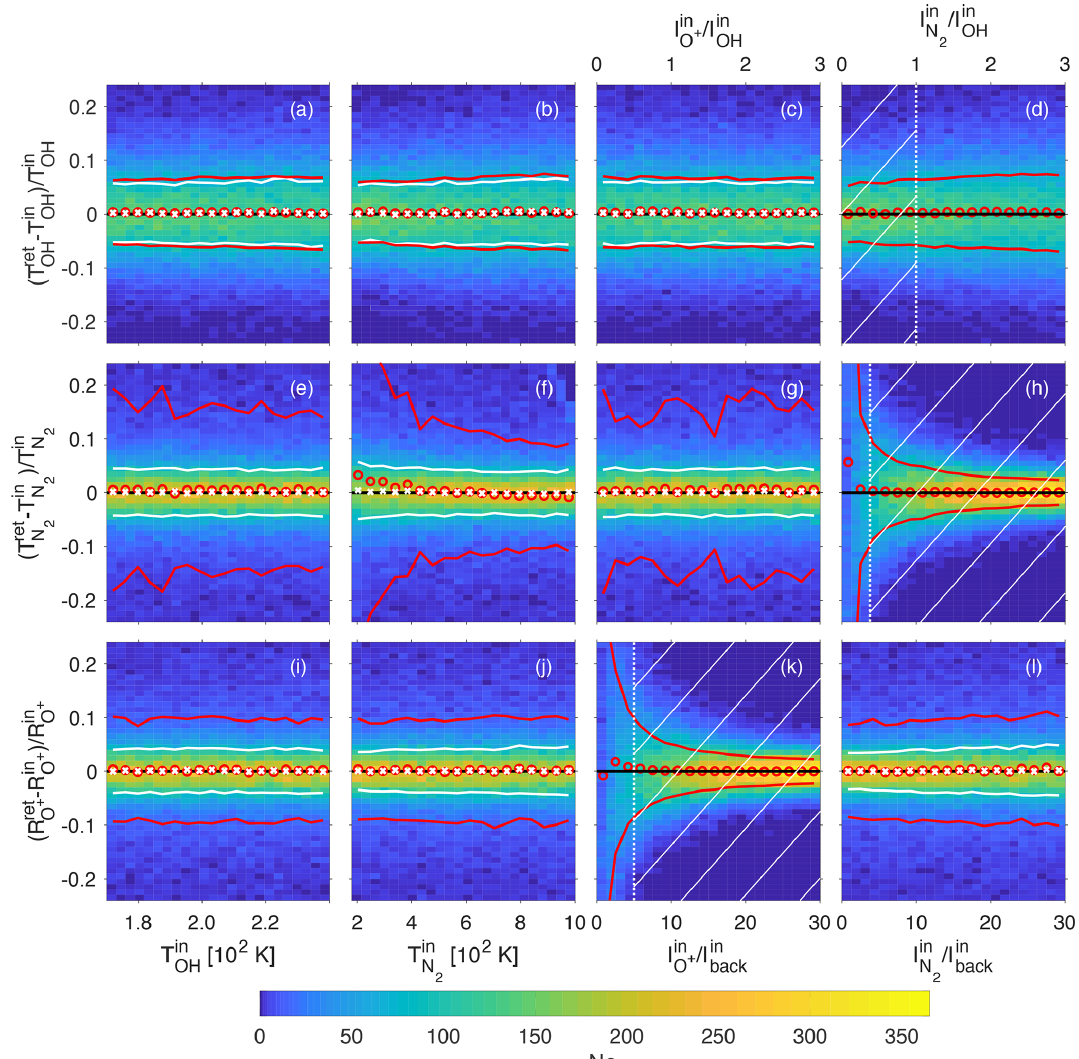
Figure 6. 2-D histograms of parameter retrieval tests using 50000 synthetic spectra. (a, b, c, d) The fractional error on the retrieval of the OH temperature T OH , (e, f, g, h) the error on the N 2 temperature, T N , and (i, j, k, l) the error on the O + ratio R O + . Panels (c, g, k) and (d, h, 2 l) show the errors as a function of the input O + and N 2 intensities, respectively. These intensities are normalised by either the OH intensity or the intensity of the background I back . Red circles indicate mean values and red lines show 1 standard deviation on either side of the mean using all of the generated synthetic spectra. (a, b, c) White crosses and thick white lines are mean values and 1 standard deviation from the mean, respectively, when the N 2 intensity parameter space is restricted to the hatched area in panel (d) . Similarly, the white crosses and lines in panels (e, f, g) represent the mean and 1 standard deviation from the mean, respectively, including only spectra with N 2 intensities within the hatched area in panel (h) . The white crosses and dotted lines in panels (i, j, l) are the mean and 1 standard deviation, respectively, including only spectra with O + intensities in the hatched area in panel (k)